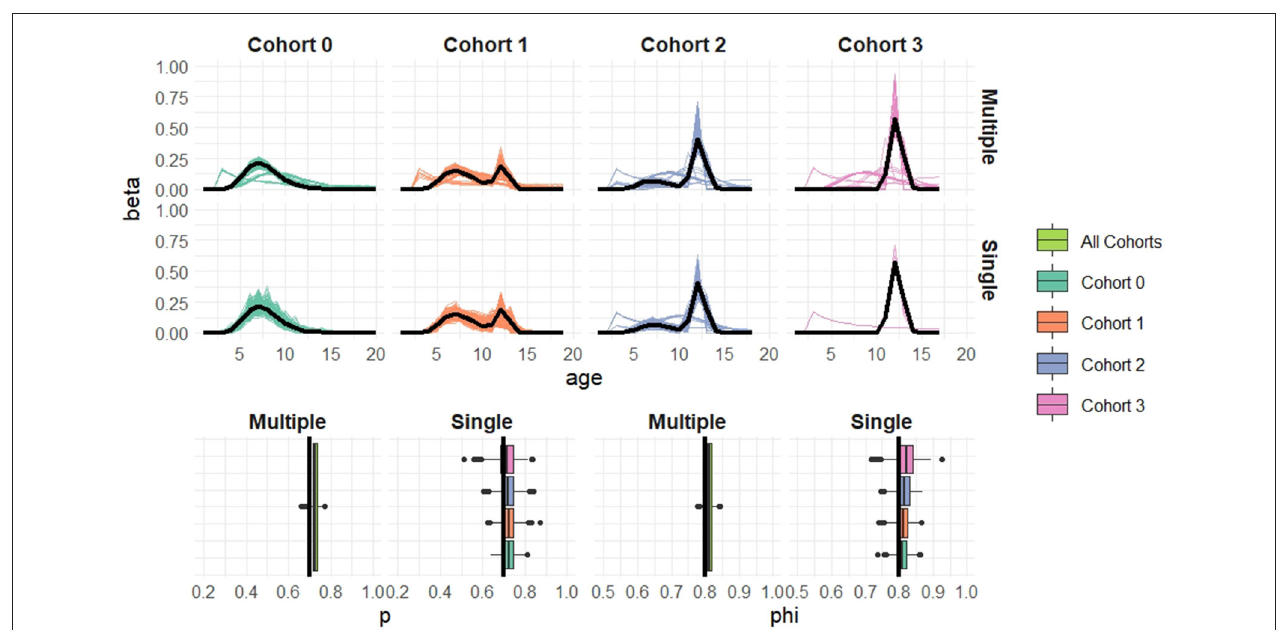
FIGURE 5 | Simulation results when cohort sample size n = 50 based on 1,000 simulated datasets. Top : Estimated recruitment distributions from the cohort-structured model. Middle : Estimated recruitment distributions from the single-cohort models. Bottom : Estimated capture and survival probabilities for the cohort-structured model (multiple) and separate single-cohort models (single). The true values are indicated by black lines.